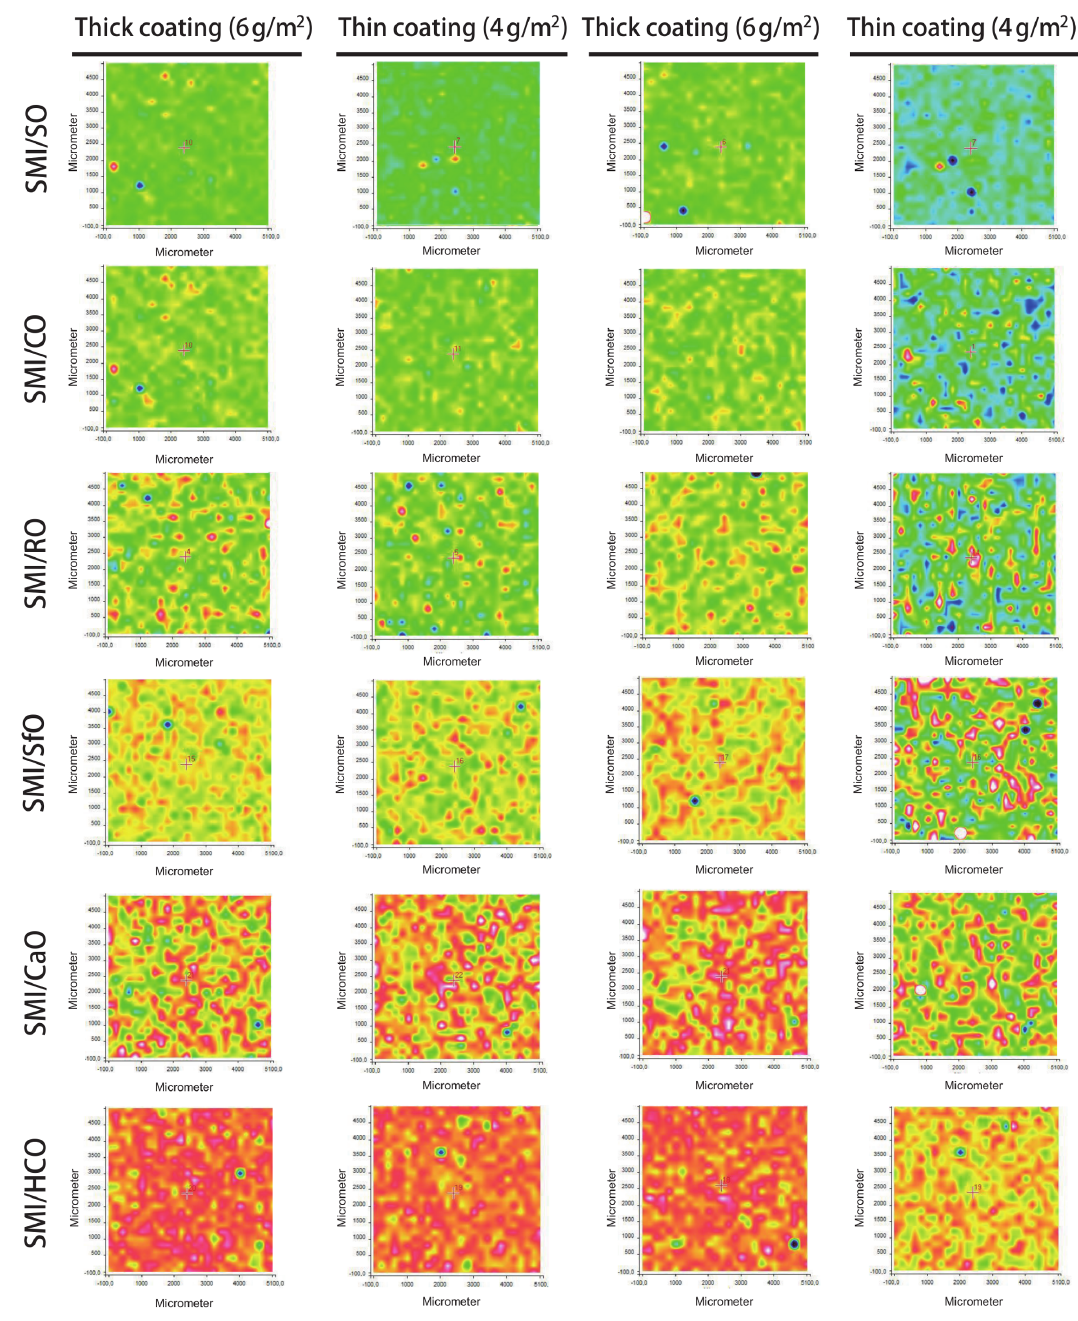
Figure 6. Raman maps (5 × 5 mm 2 ) with band intensity ratios illustrating exposure of oil at the surface for SMI/oil paper coatings (left two columns: oil/styrene; right two columns: